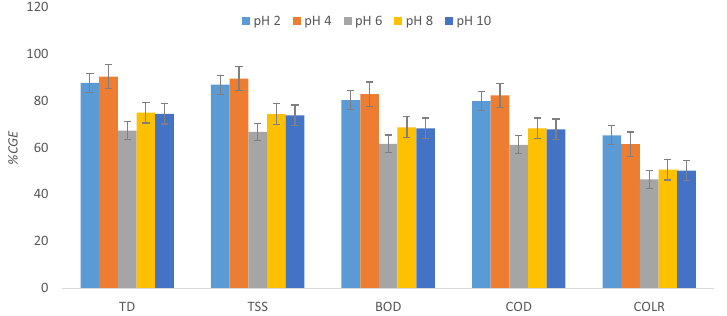
Figure 7. Effect of AQEF pH on pollutants elimination at 60 min and 0.2 g L −1